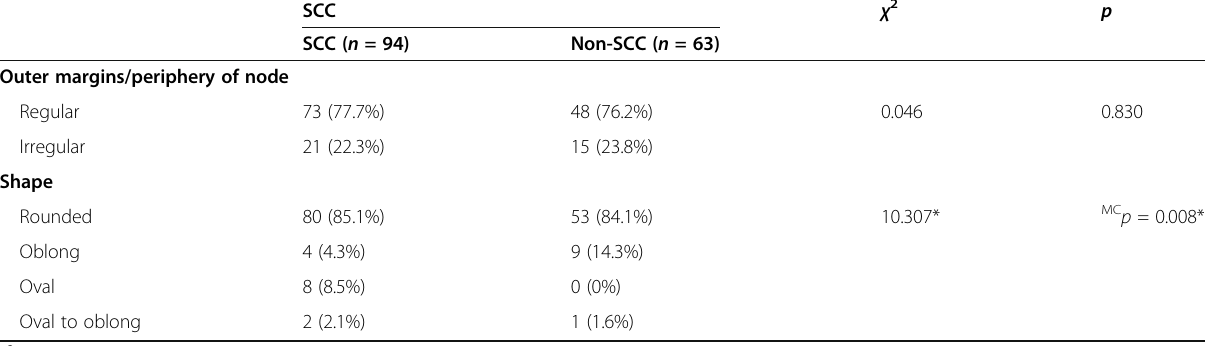
Table 5 Comparison between the two studied groups according to different parameters: margins and shape SCC χ 2 p SCC ( n = 94) Non-SCC ( n = 63) Outer margins/periphery of node Regular 73 (77.7%) 48 (76.2%) 0.046 0.830 Irregular 21 (22.3%) 15 (23.8%) Shape Rounded 80 (85.1%) 53 (84.1%) 10.307* MC p = 0.008* Oblong 4 (4.3%) 9 (14.3%) Oval 8 (8.5%) 0 (0%) Oval to oblong 2 (2.1%) 1 (1.6%) χ 2 chi-square test, MC Monte Carlo, p p value for comparing between the two studied groups *Statistically significant at p ≤ 0.05